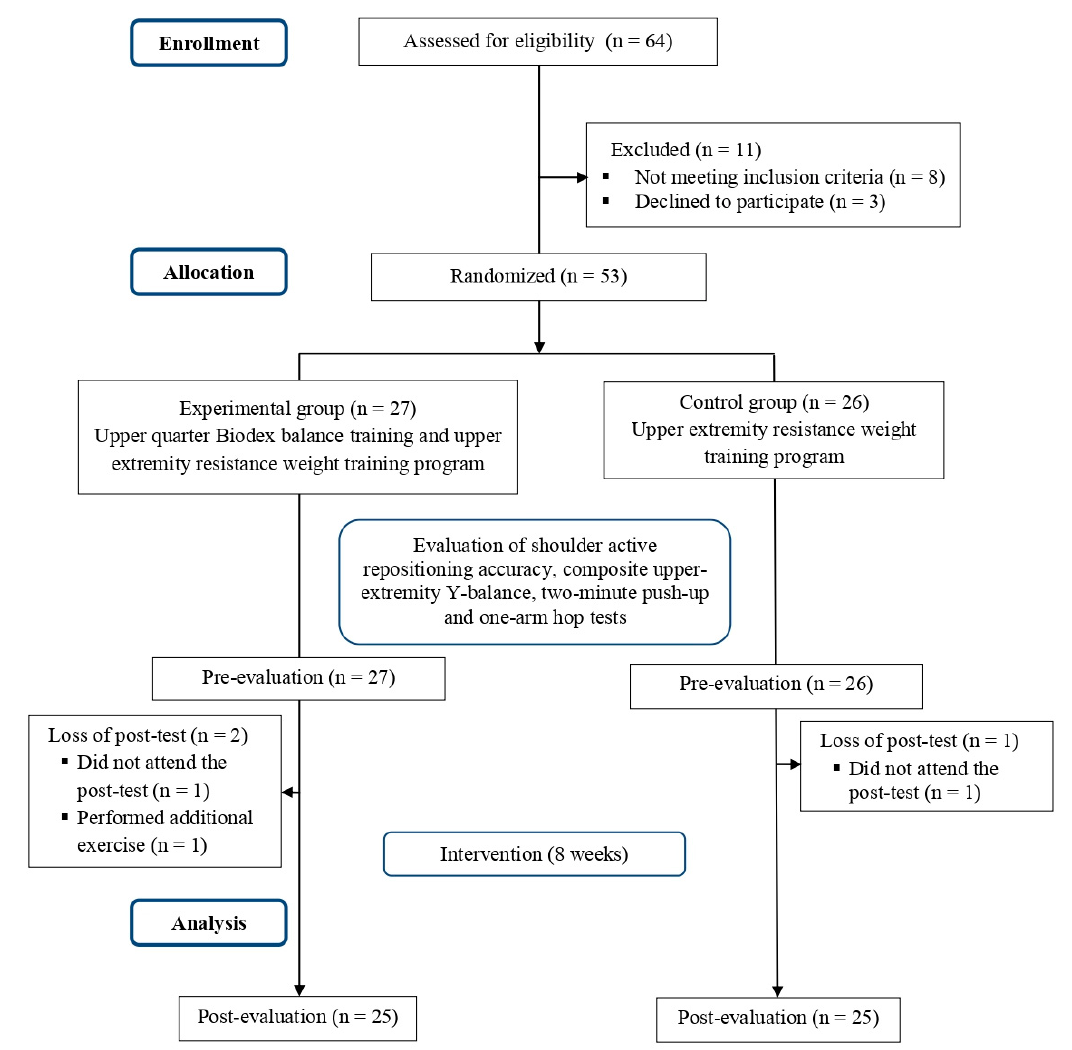
Figure 1. Flowchart of the study processes.